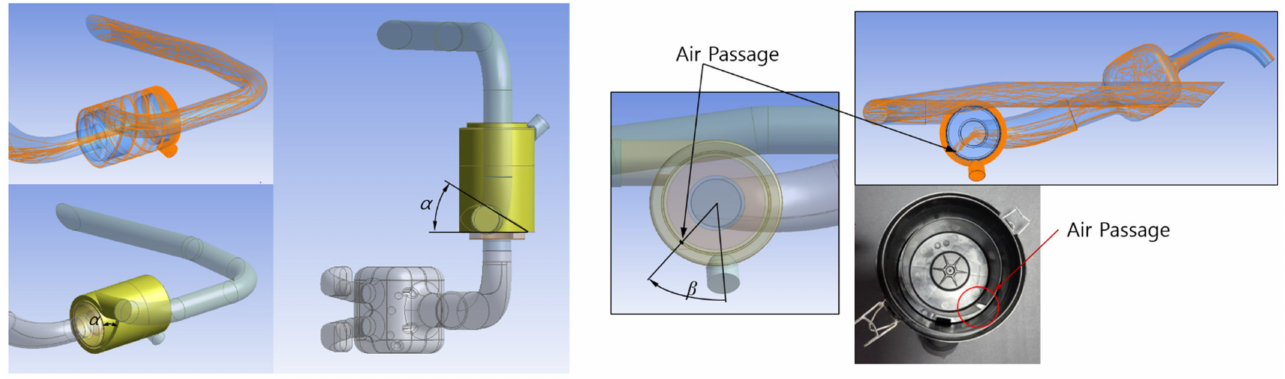
Figure 4. Definition of design variables α and β .